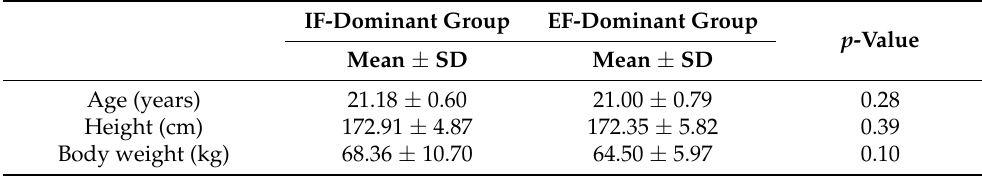
Table 1. Characteristics of the IF-dominant group ( n = 11) and EF-dominant group ( n = 20). IF-Dominant